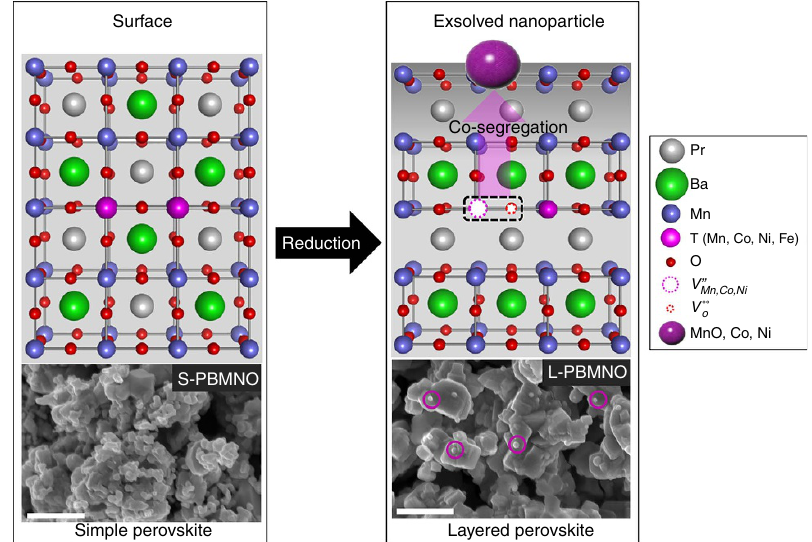
Figure 2 | Exsolution of B-site cation with oxygen from layered perovskite in a reducing atmosphere. The SEM images present surface morphologies of Pr 0.5 Ba 0.5 Mn 0.85 Ni 0.15 O 3 before reduction and PrBaMn 1.7 Ni 0.3 O 5 þ d after reduction in humidified (3% H 2 O) H 2 at 800 (cid:2) C for 4h; scale bar 500nm. In the SEM image of